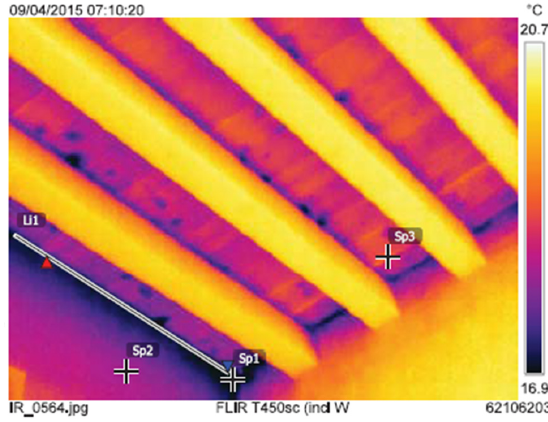
Figure 5. Thermal bridges on the roof, East façade.